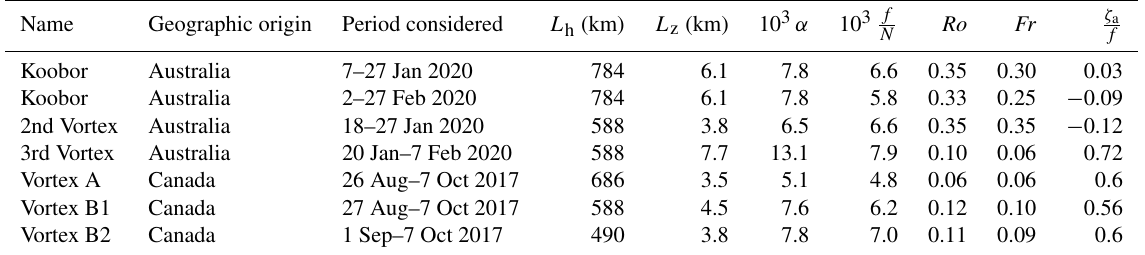
Table 1. The horizontal diameter ( L h ), vertical depth ( L z ), aspect ratio ( α ), QG aspect ratio imposed by the environment ( f number, Froude number and maximum vorticity ( ζ a ) of the six smoke-charged pancake vortices originating from the Canadian (2017) and f Australian (2020) wildfires. The 2020 Koobor vortex was long-lasting and is decomposed into two periods